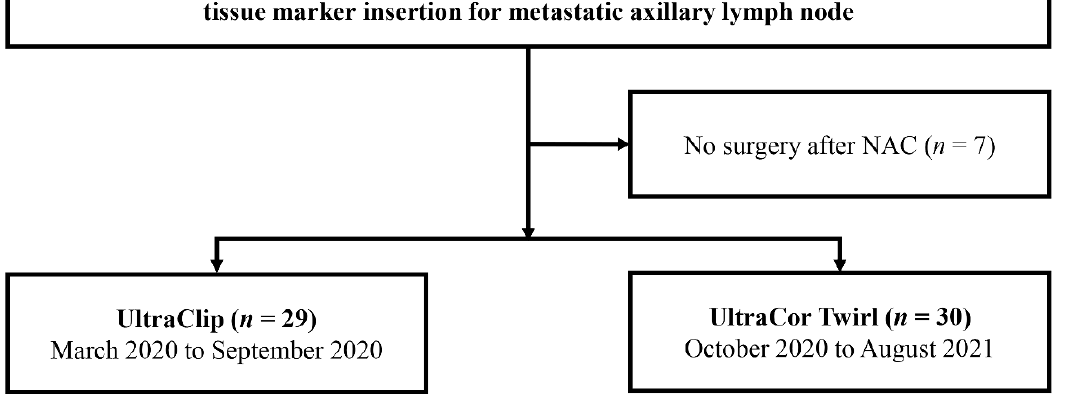
Figure 1. Flowchart of the participant selection process.